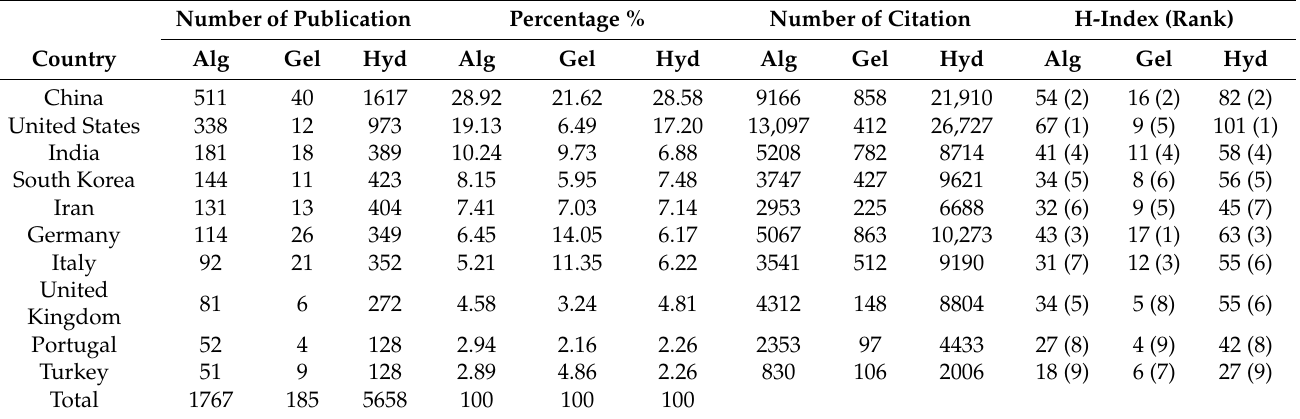
Table 3. Scientific publications by country (2009–2019).